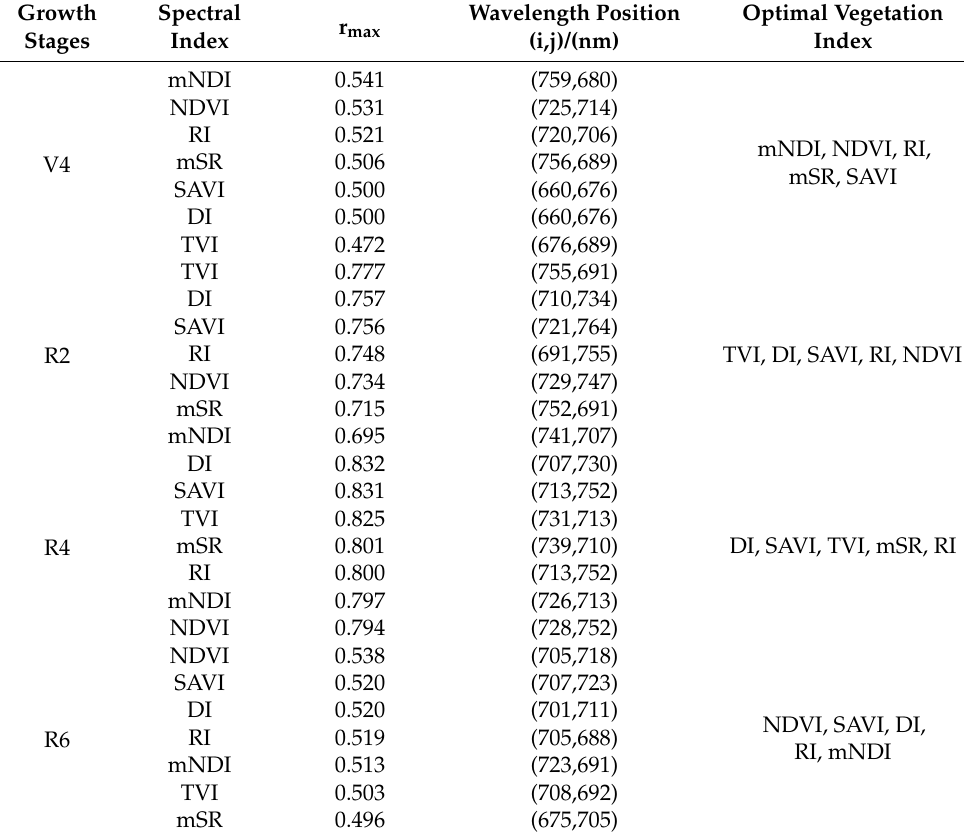
Table 3. Optimal vegetation index wavelength combinations at different growth